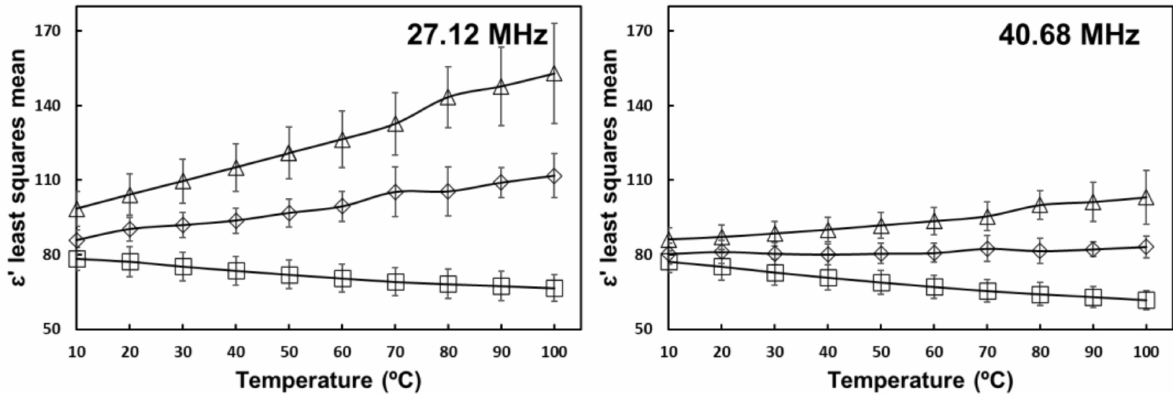
Figure 1. Salt and temperature interaction effect on the dielectric constant of tomato homogenate at 27.12 MHz and 40.68 MHz. ( ) 0% salt ( ) 0.5% salt ( ) 1% salt. Error bars correspond to standard